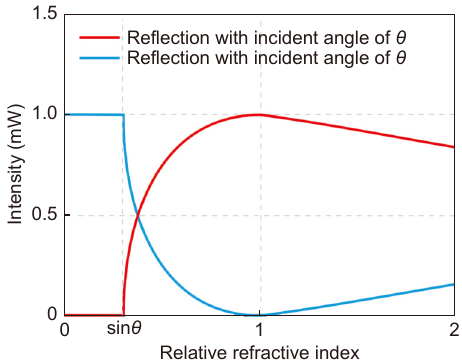
Fig. 2 | The relationship between the energy of reflected and re- fracted light and the relative RI when the incident angle is θ